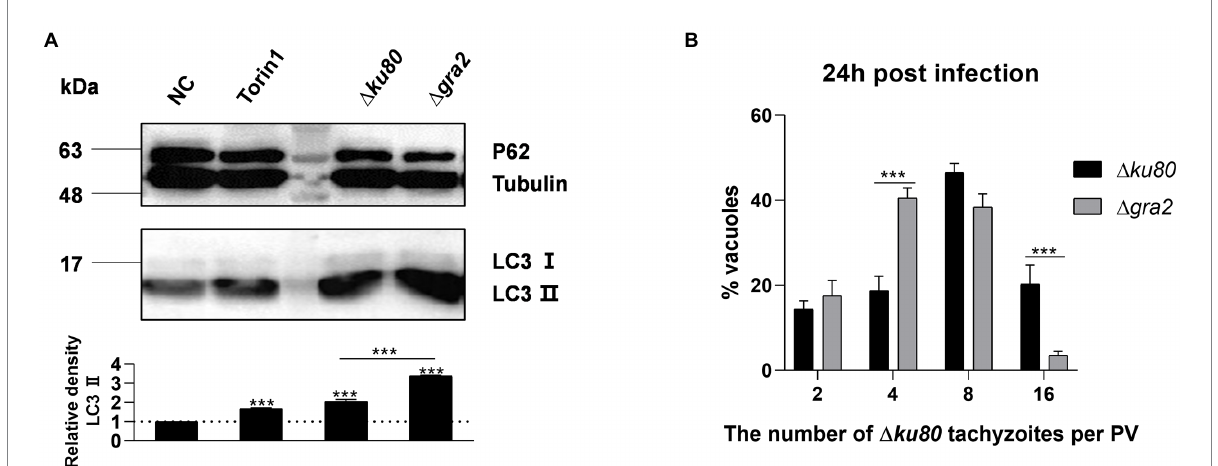
FIGURE 8 Toxoplasma gondii GRA2 deficiency results in greater LC3 II accumulation of the host cell and slower replication of the parasite. (A) HeLa cells untreated, treated by Torin1, ∆ ku80, and ∆ gra2 infection were harvested and prepared at 24 h post-infection, and proteins of equal amounts of cell lysates were separated on 15% SDS-PAGE gels. LC3 (16 ~ 18 kDa) and p62 (~62 kDa) were detected using rabbit anti-LC3 monoclonal antibody and rabbit anti-p62 monoclonal antibody, Tubulin (~55 kDa) expression was detected using mouse anti- β -tubulin polyclonal antibodies as a loading control. Relative densities of LC3 II were the ratios of the densities of LC3 II to the densities of Tubulin. The relative densities of the negative controls were set as one arbitrary unit whereas those of the treated groups were ratios to the negative controls. Each value is the mean ± SEM of three measurements (*** p ≤ 0.001; t -tests). (B) HFF-1 cells were challenged by T. gondii RH ∆ ku80 and RH ∆ ku80 ∆ gra2 tachyzoites at an MOI of 2:1 and fixed by methanol at 24 h post-infection. Intracellular replication of parasites was determined by the proportion of vacuoles containing 2, 4, 8, and 16 or more tachyzoites. Each value is the mean ± SEM of three counts (*** p ≤ 0.001; two-way